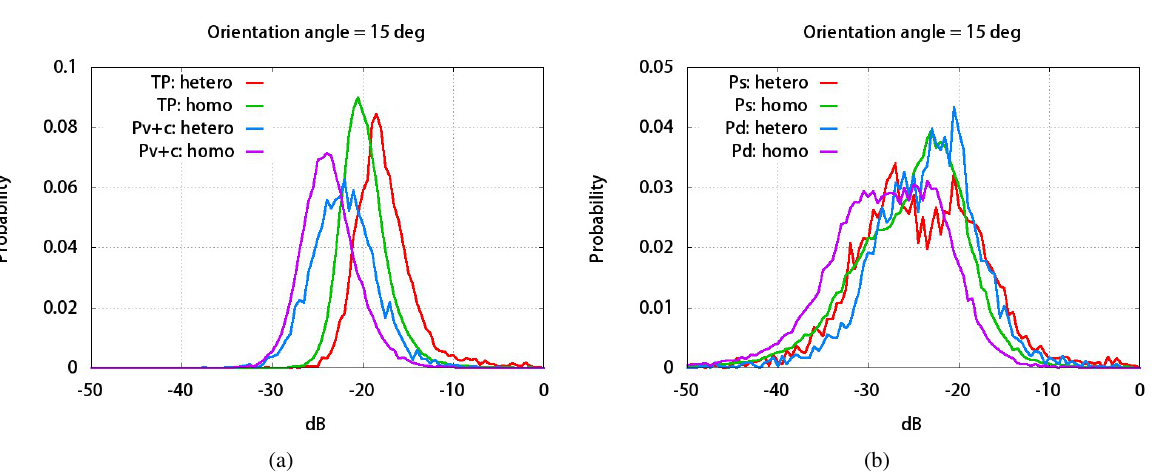
Figure 10. Histograms of scattering of areas having POA around 15 ◦ (13 ◦ (cid:20) POA (cid:20) 17 ◦ from PALSAR image of the study area. See the caption of Fig. 5.